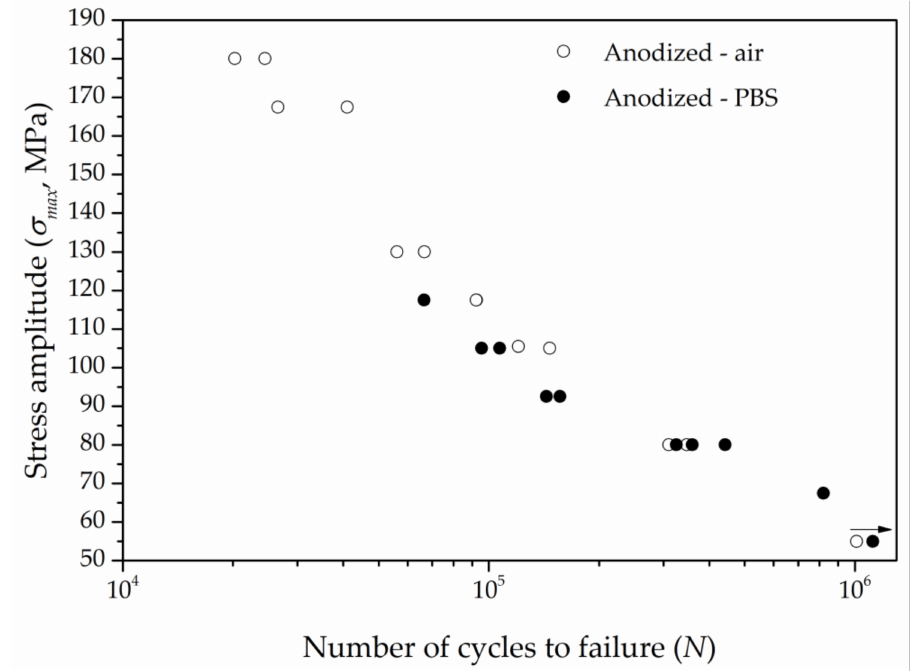
Figure 6. S- N curvesfortheanodizedAZ31BalloyspecimensinairandinPBSsolutionatroomtemperature.